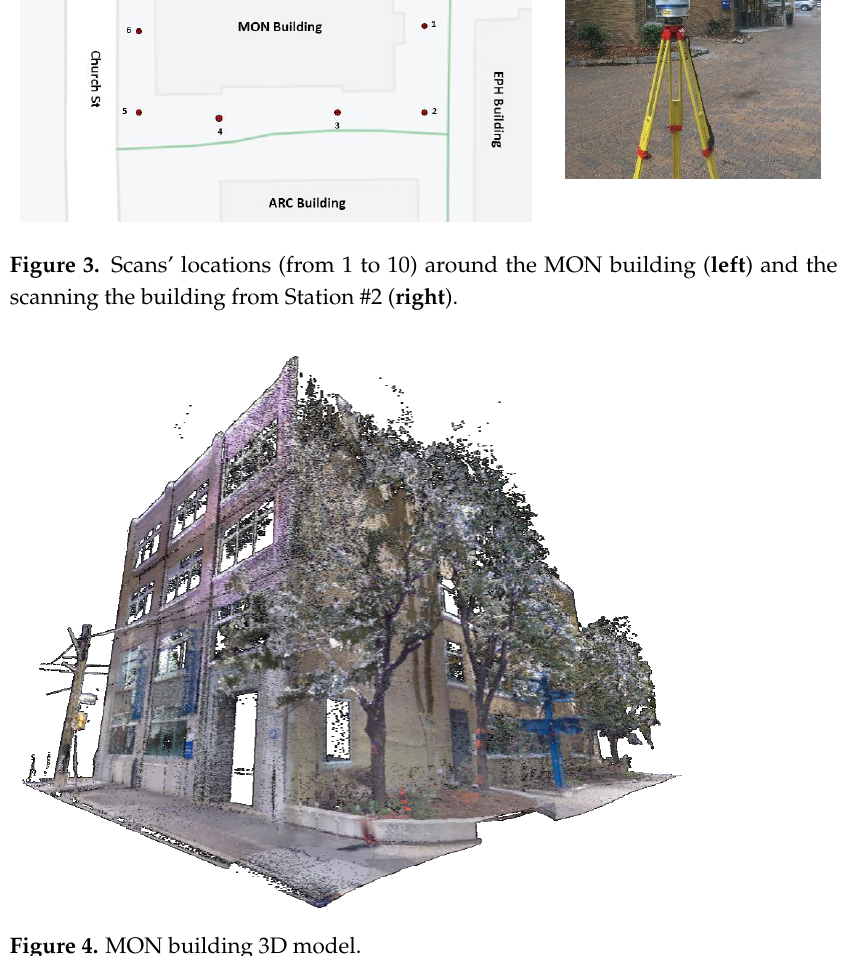
Figure 4. MON building 3D model.